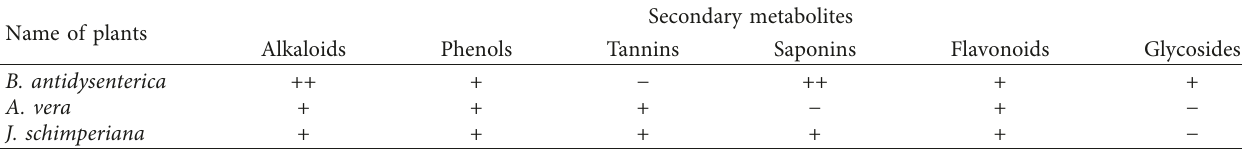
Table 2: Results of preliminary phytochemical screening tests of methanolic plant extracts. Name of plants